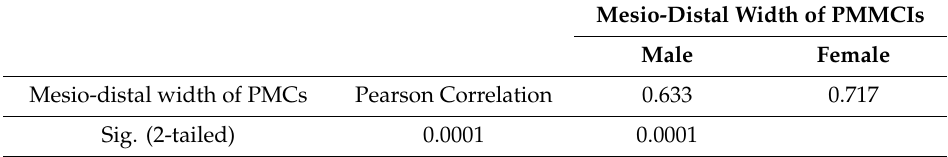
Table 2. Pearson correlation coe ffi cient between permanent maxillary canines and permanent maxillary and mandibular central incisors.